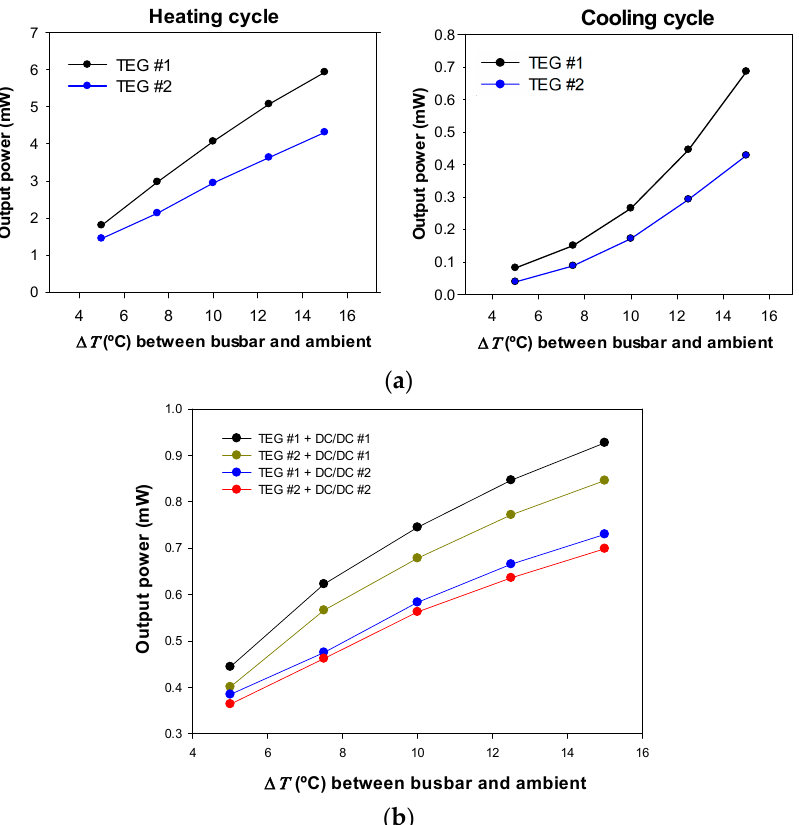
Figure 5. Combined performance of TEGs #1 and #2 combined with DC/DC converters #1 and #2. ( a ) Power generated by the analyzed TEG modules versus the temperature difference between the busbar and the ambient during the heating and cooling cycles. ( b ) Output power of the different combinations of TEG + DC/DC converter versus the temperature difference between the busbar and the ambient during the heating cycle.